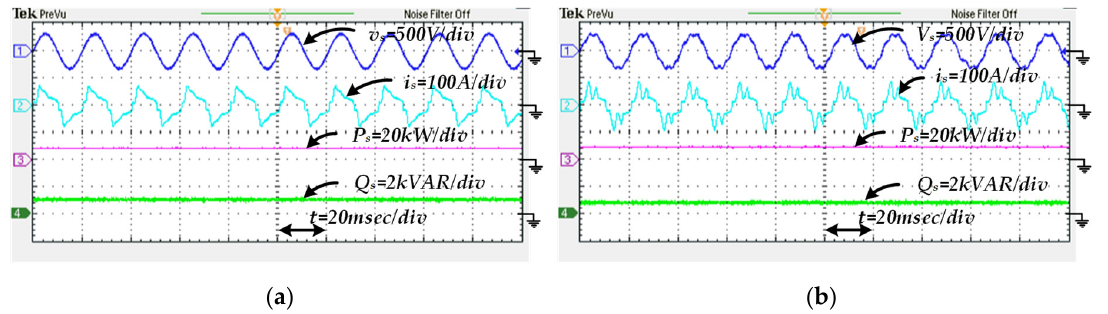
Figure 13. RT SIL test waveforms under MFI OFF mode under ( a ) the ideal grid and ( b ) the distorted grid.